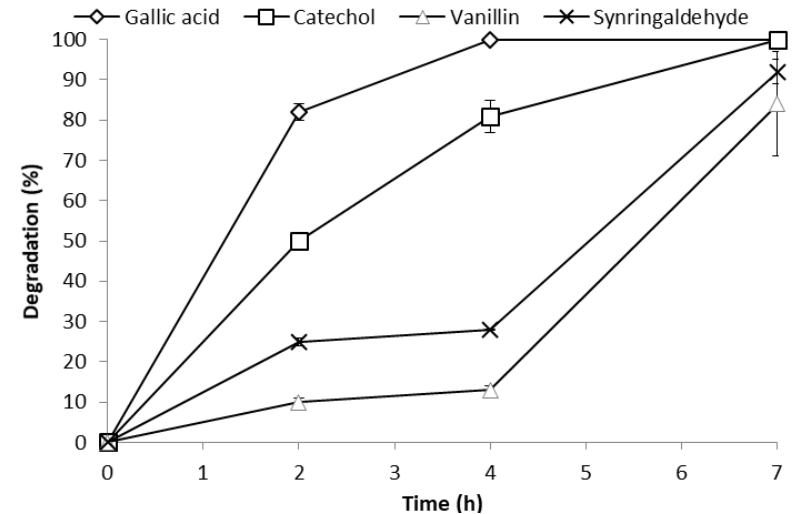
Figure 4. Degradation of the individual phenolic compounds using the solid laccase enzyme as a function of time.